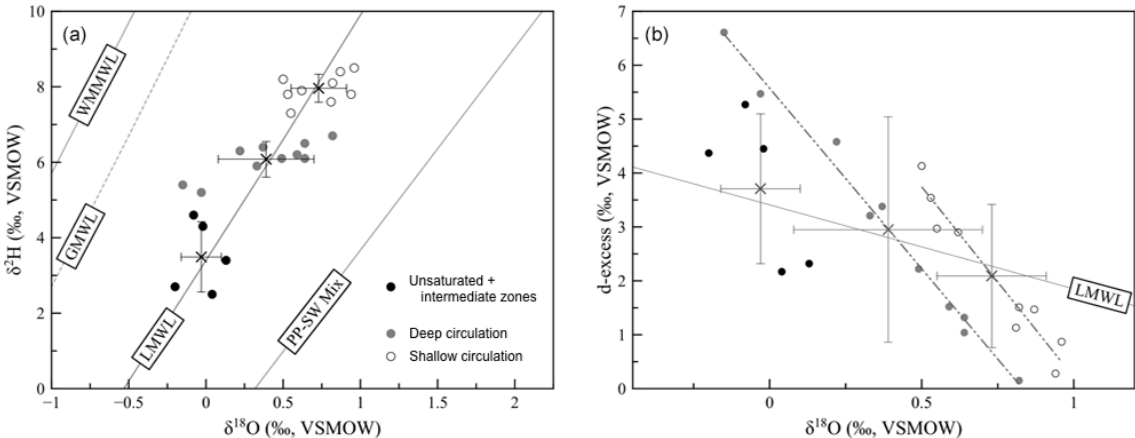
Figure 5. Isotopic composition of porewater extracted in winter 2010/2011 (Table S1) at different depth levels below the surface at the saturated zone and the dynamics of the beach groundwater table. (a) frames the compositional range and the subdivision of the isotopic characteristics through three groups, corresponding to different circulation paths within the beach (for an explanation, see Sect. 4.2.3). (b) frames the same samples in a deuterium-excess ( d) vs. δ 18 O plot, illustrating the progression of evaporative enrichment throughout the three zones and its relationship with the LMWL (Local Meteoric Water Line, Carreira et al 2005). Crosses and attached error bars represent average compositions for each group. Error bars represent the ± 1SD PP–SW mix: precipitation–seawater mixing line (Sect. 4.2.1); EMMWL: Eastern Mediterranean Meteoric Water Line (Gat and Carmi, 1970); WMMWL: Western Mediterranean Meteoric Water Line (Celle-Jeanton et al., 2001); GMWL: Global Meteoric Water Line (Clark and Fritz, 1997).